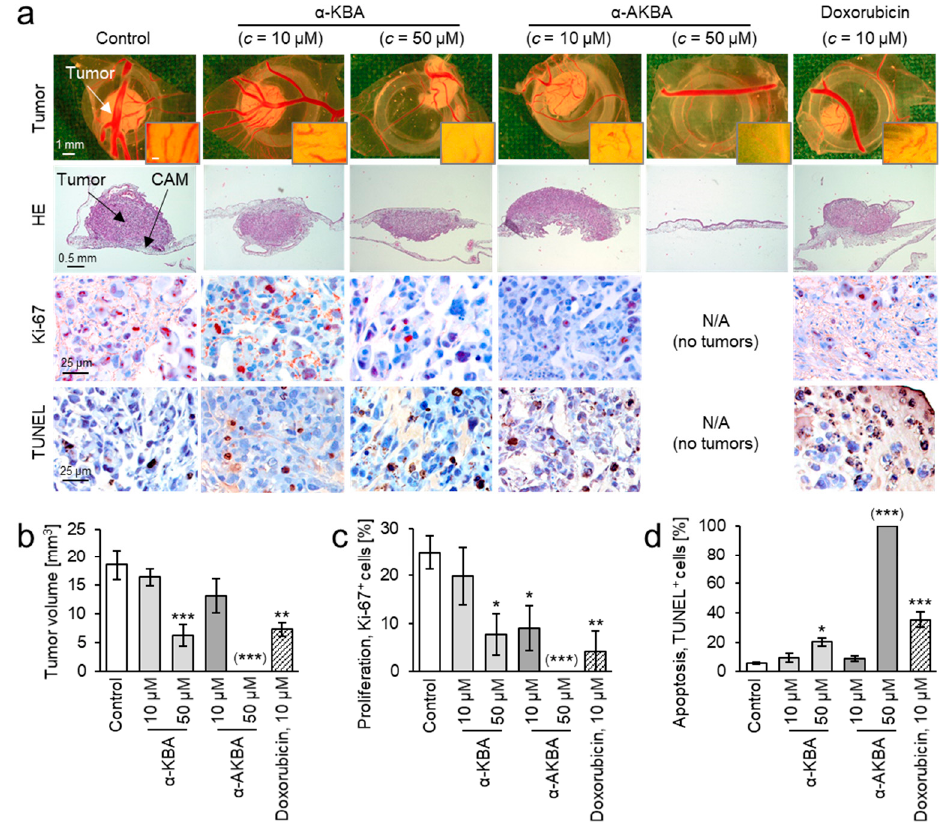
Figure 8. 11-keto- α -boswellic acid ( α -KBA) and acetyl-11-keto- α -boswellic acid ( α -AKBA) inhibit proliferation and tumor growth and induce apoptosis in breast cancer xenografts in vivo. MDA-MB-231 cells were grafted onto the chorioallantoic membrane (CAM) of fertilized chick eggs and treated for 3 consecutive days with either α -KBA (10 and 50 µ M), α -AKBA (10 and 50 µ M), doxorubicin (10 µ M), or DMSO (0.5%) as vehicle control. After treatment with 50 µ M α -AKBA, no tumors could be observed. Hence, results for α -AKBA (50 µM) are considered as 0% proliferating cells or 100% apoptotic cells and delineated in brackets. ( a ) 1st row: tumor photographs immediately after extraction (original magnification 50×). Inserts: peritumoral blood vessels (bar: 100 µ m). 2nd row: hematoxylin and eosin staining. 3rd row: staining for proliferation marker Ki-67 (red-brown nuclear stain, original magnification 200x). 4th row: TUNEL (terminal deoxynucleotidyl transferase dUTP nick end labeling) staining for apoptosis (brown, original magnification 200x). Representative pictures are